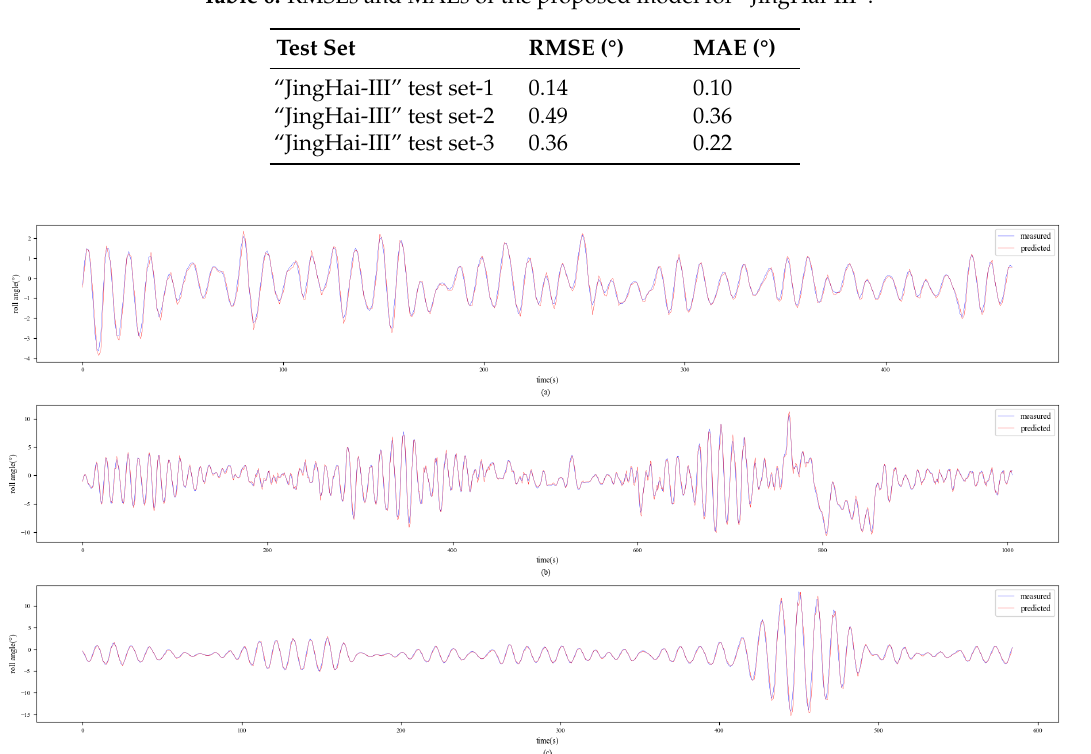
Table 6. RMSEs and MAEs of the proposed model for “JingHai-III”.